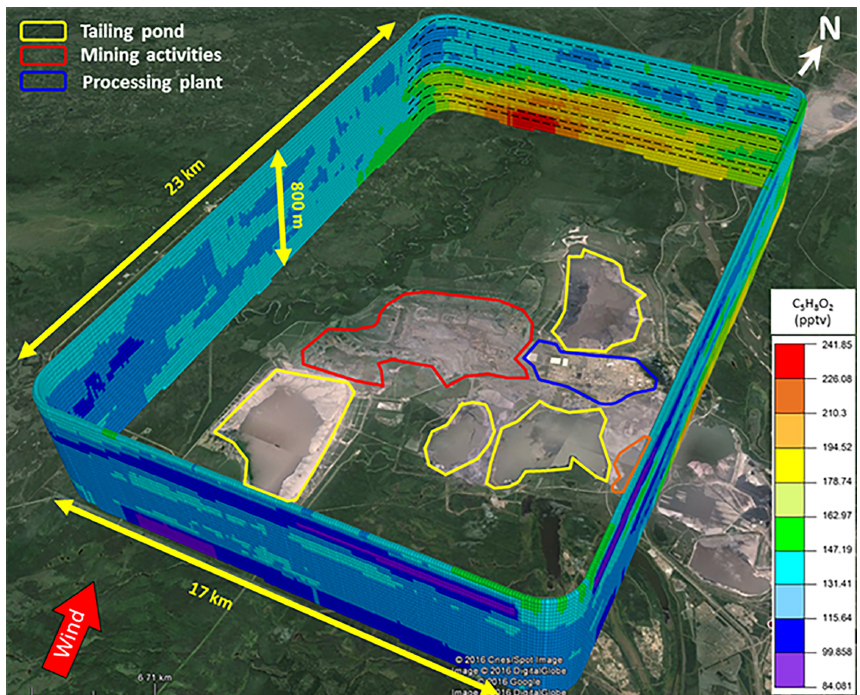
Figure 1. Emissions box flight during Flight 18 on 3 September 2013 (Syncrude – ML) as outputted from TERRA for a typical measured organic acid (C 5 H 8 O 2 ) . Data have been kriged to produce a continuous concentration surface around various oil sands operation sources. Dashed black lines represent approximate locations of the flight tracks on one box